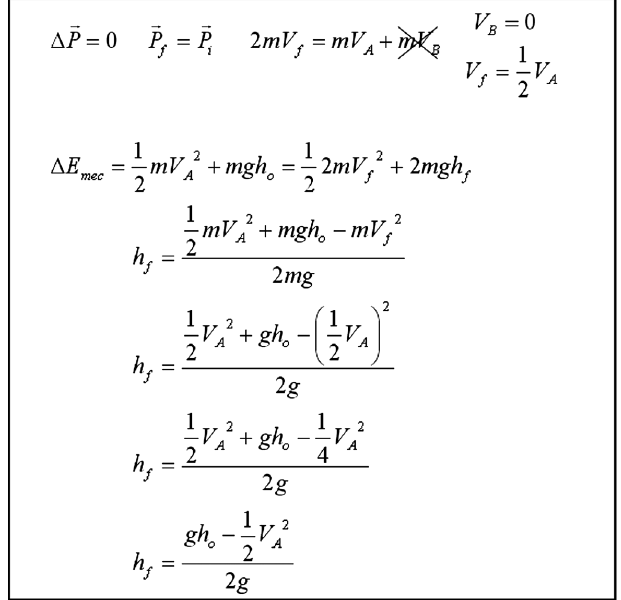
FIG. 2. An example of a student’s incorrect answer. The situ- ations in which the CM and CME principles were applied are not